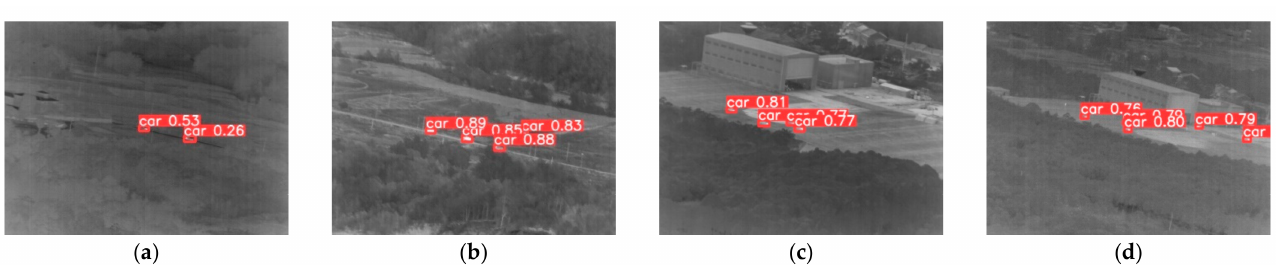
Figure 21. YOLOv5 detection map. ( a ) Scene 1. ( b ) Scene 2. ( c ) Scene 3. ( d ) Scene 4.